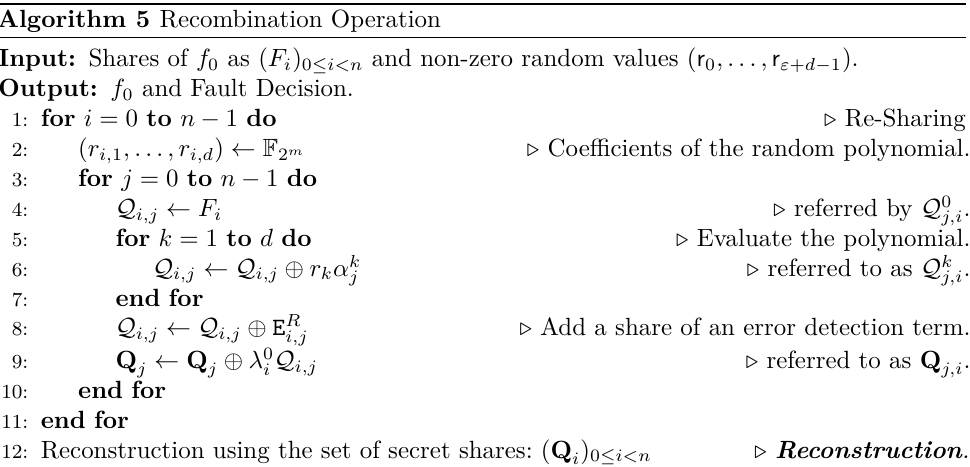
Algorithm 5 Recombination